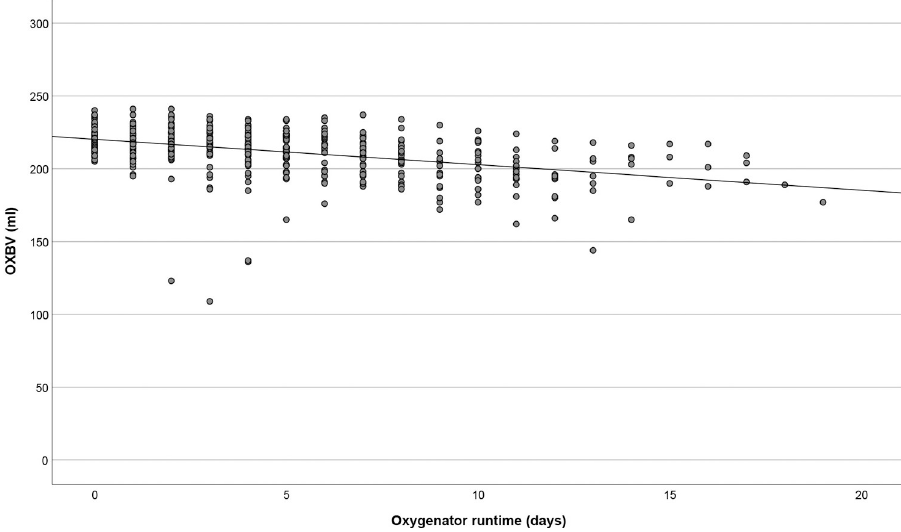
Fig 1. Oxygenator blood volume during the extracorporeal life support runs. OXBV = oxygenator blood volume.